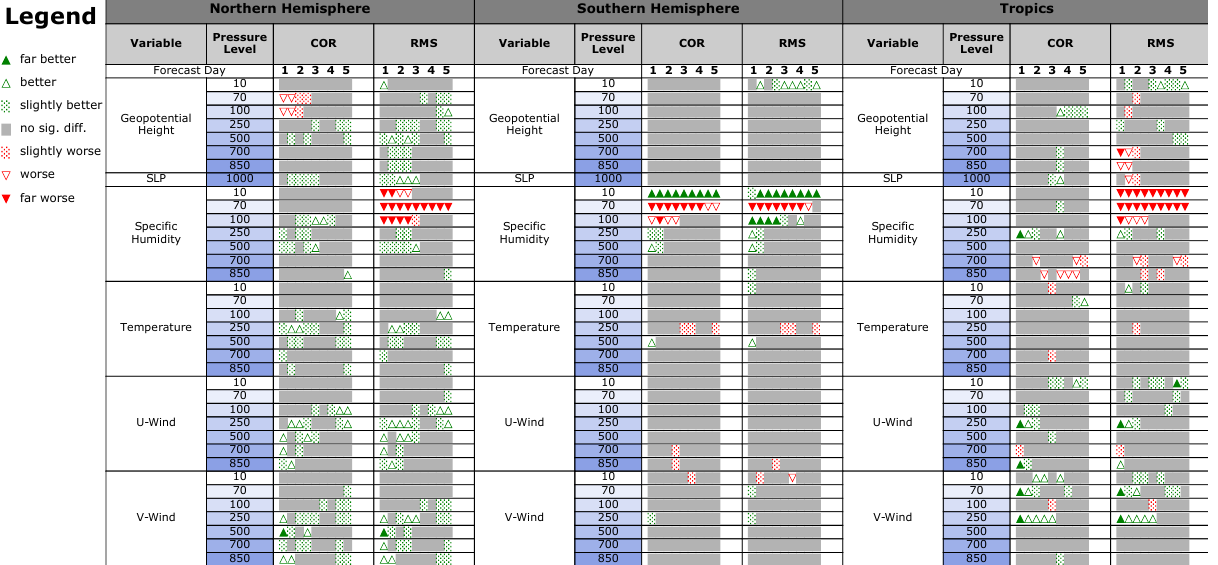
Figure 12. Scorecard comparing CNTL and NOH8, when both are verified against ERA-5 analyses, and NOH8 is used as reference. This shows the effectiveness of adding H-8 AMVs to a configuration of GEOS that uses no H-8. The three scorecard panels are for Northern Hemisphere (left), South- ern Hemisphere (middle) and Tropics (right). Scores are derived for the two month period